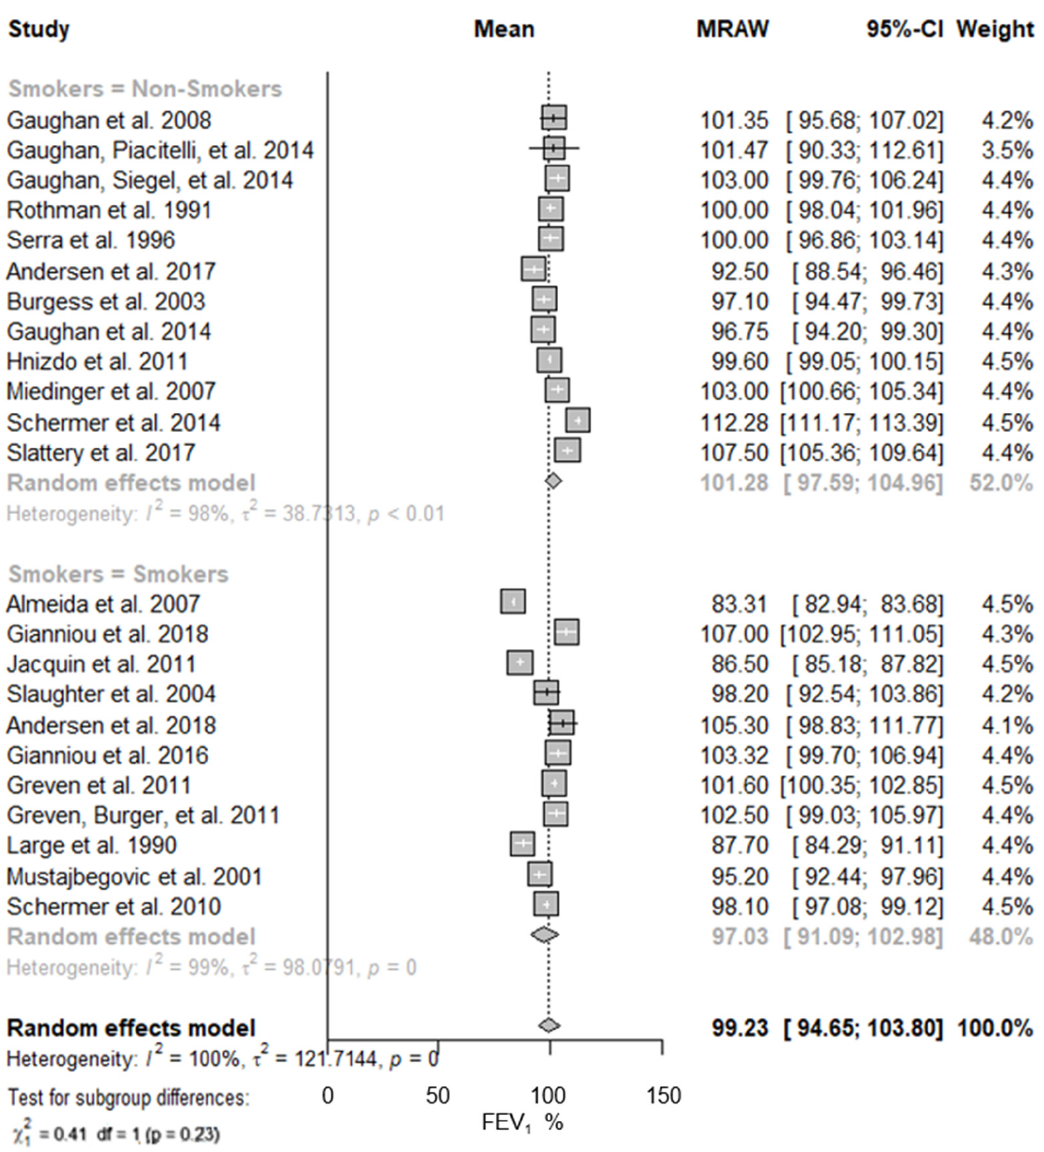
Figure 5. Predicted FEV 1 in firefighters stratified by smoking practices. Forest plot displaying the weight of the predicted FEV 1 mean value and heterogeneity. “Non-smokers” was assigned to all the studies wherein less than or equal to 10% of the participants were smokers, and “Smokers” was assigned to the studies wherein more than 10% of the participants were smokers [13,40–54,56–62]. In Figure 6, no significant differences were identified between firefighters that com- bat wildland fires (mean: 97.64%; 95% CI: 91.45–103.82%; I 2 = 99%) and those fighting other/urban fires (mean: 99.71%; 95% CI: 96.75–102.67%; I 2 = 98%). Similarly, there was no difference in the predicted FVC mean values (Table